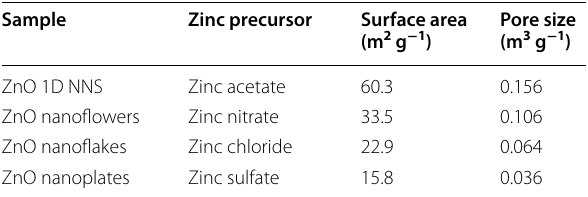
Table 1 The surface area and pore size of the four kinds of ZnO nanostrucutres